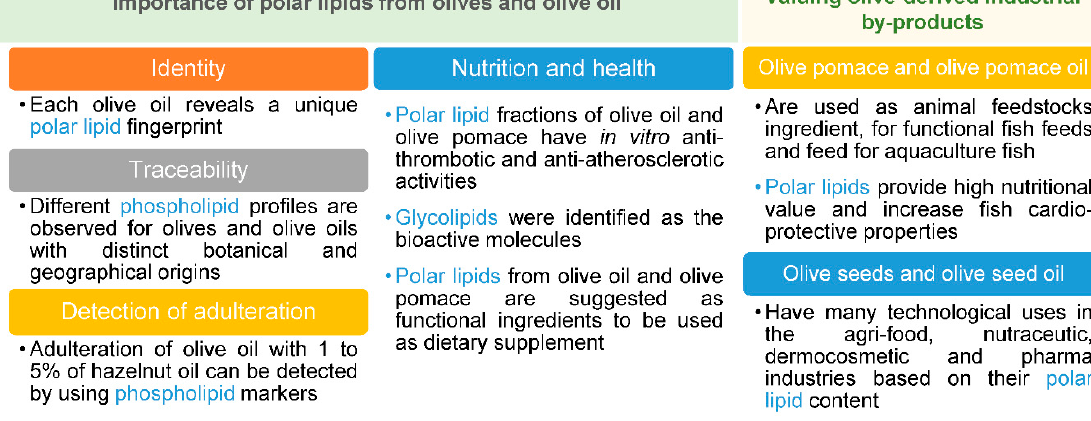
Figure 3. Resume on the importance of polar lipids from olives, olive oil, and their by-products.